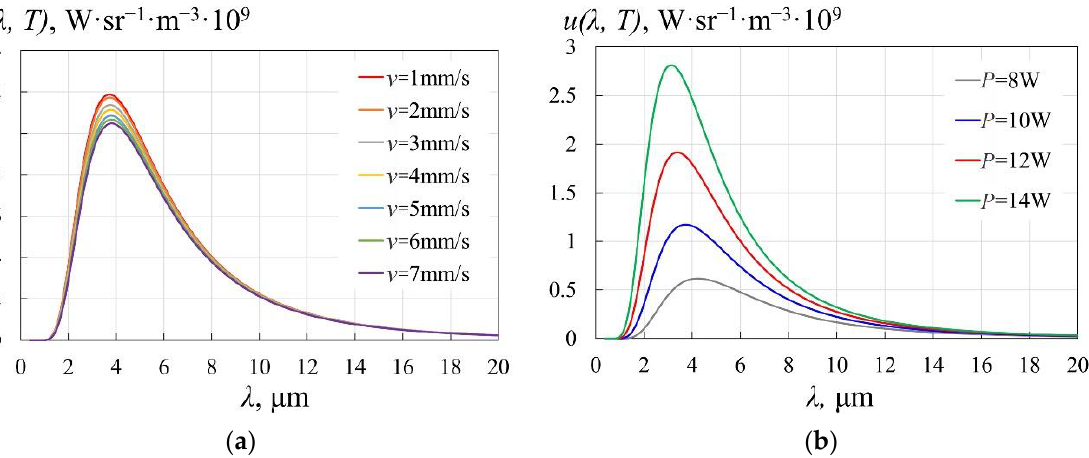
Figure 8. Spectral luminosity densities TOTFC ( u ( λ , T )) at an average laser radiation power P = 10 W for traction speeds ( ν ) in the range 1 – 7 mm/s ( a ) and at ν = 2 mm/s for P in the range 8 – 14 W ( b ) (the wavelength of laser radiation is 980 nm, the inner vein diameter is 5 mm).